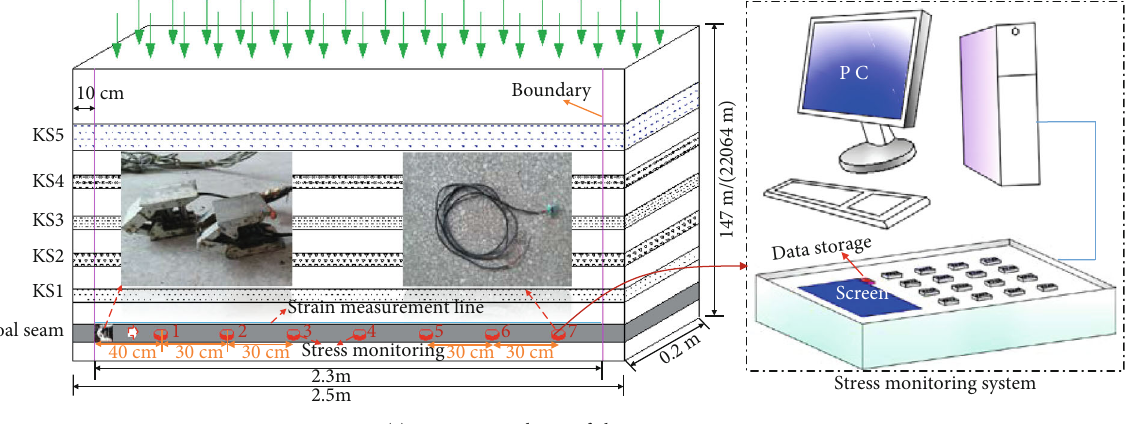
Figure 2: Monitoring system of the physical